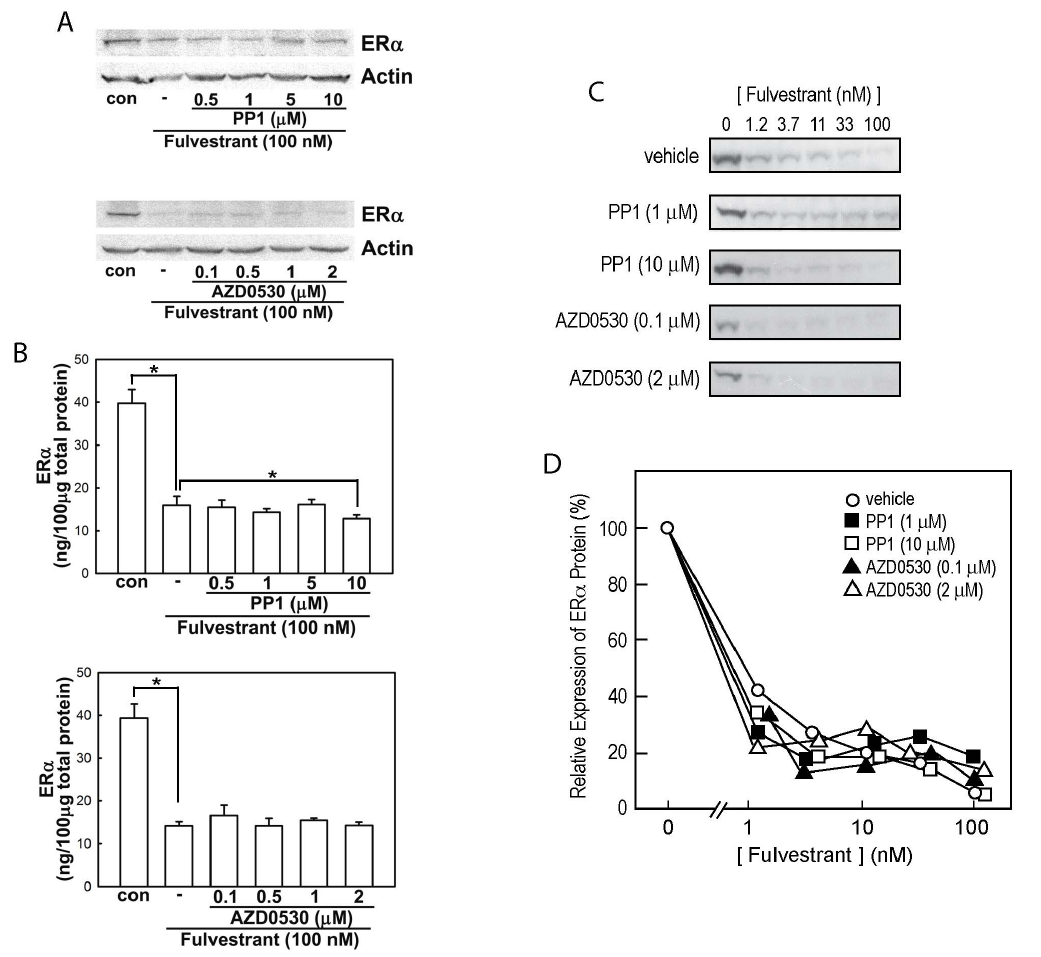
Figure 5. PP1 or AZD0530 tyrosine kinase inhibitors had no effect on ER a protein degradation in MCF-7 cells. In panels ( A ) and ( B ), ER a protein expression after 6-hour exposure to 100 nM fulvestrant in the presence of PP1 or AZD0530 was determined by Western blotting (A) and ELISA (B, mean 6 SEM of three or more independent experiments. Asterisks indicate statistical significance, p , 0.05, to fulvestrant-only group). In panels ( C ) and ( D ), fulvestrant concentration was reduced as indicated, and ER a protein expression after 6-hour exposure in the presence of PP1 or AZD0530 was determined by Western blotting ( C ). Panel ( D ) shows a typical densitometric quantitation of the ER a protein band. Three independently performed experiments did not show statistically significant effects of PP1 or